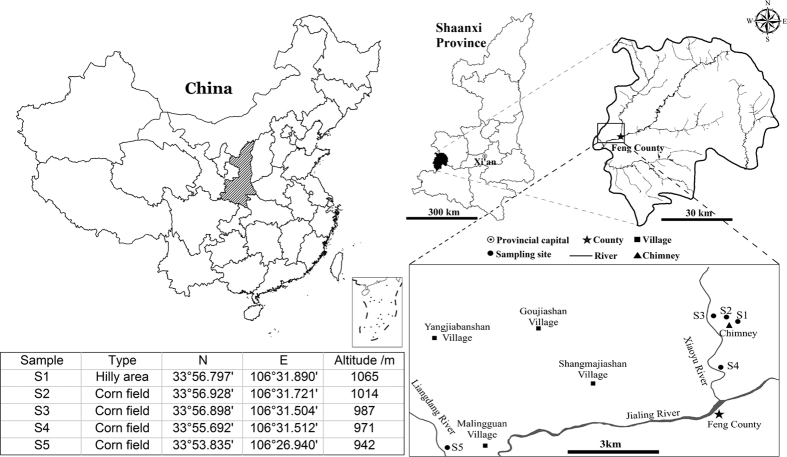
Sampling sites in the Dongling zinc smelter area.The smelter is located in Feng County, Qinling Mountain area of Shaanxi Province of China. The distance from the main chimney of S1 to S5 was 0.05, 0.05, 0.50, 2.00 and 10.00 km respectively. The maps within Fig. 1 were created using “ESRI’s ArcGIS 9.0 software (http://www.esri.com/software/arcgis)”.